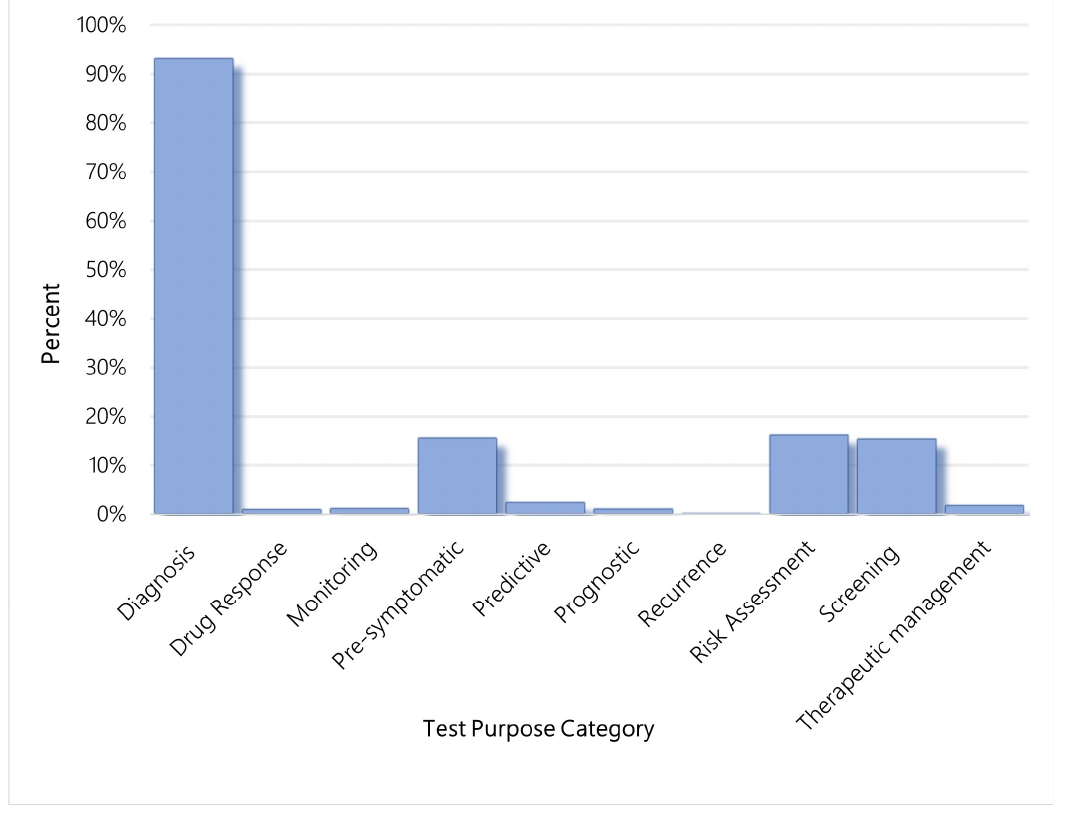
Figure 1. Percent of current genetic tests within each test purpose category, US.